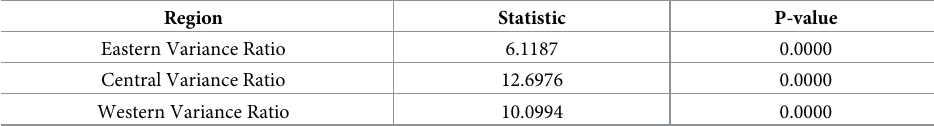
Table 12. Co-integration test of eastern, central, and western regions of China.